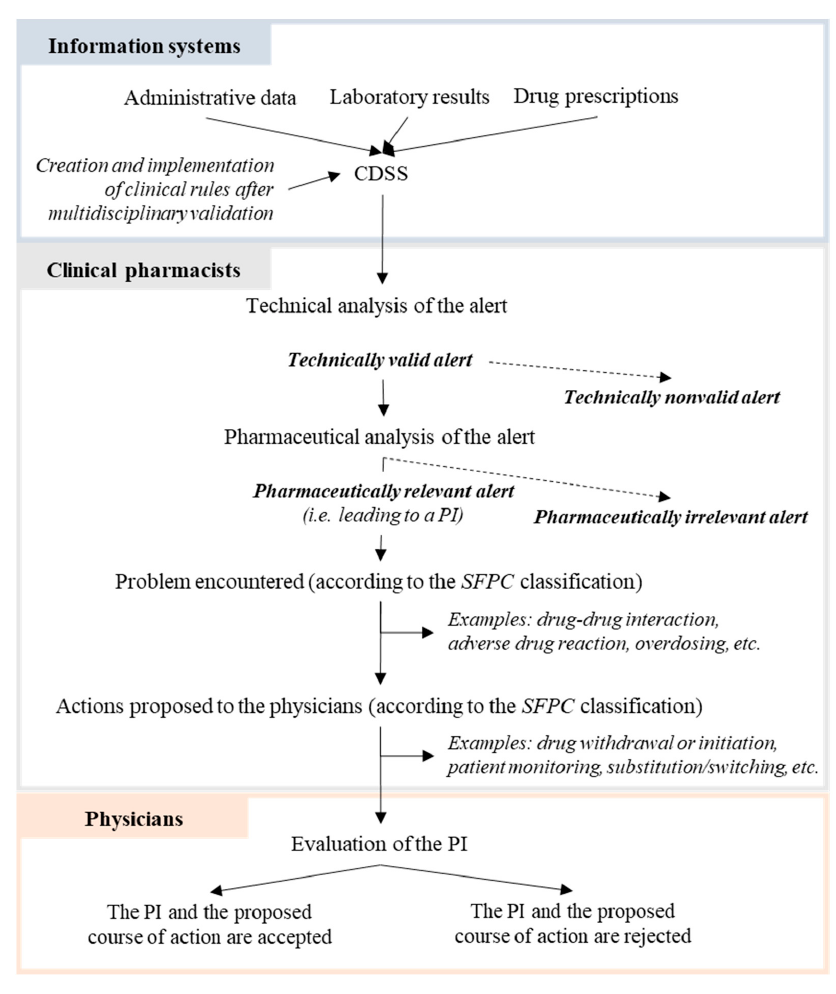
Figure 1. Analysis of CDSS alerts by the clinical pharmacists. CDSS: clinical decision support system; PI: pharmacist intervention; SFPC: French Society of Clinical Pharmacy.